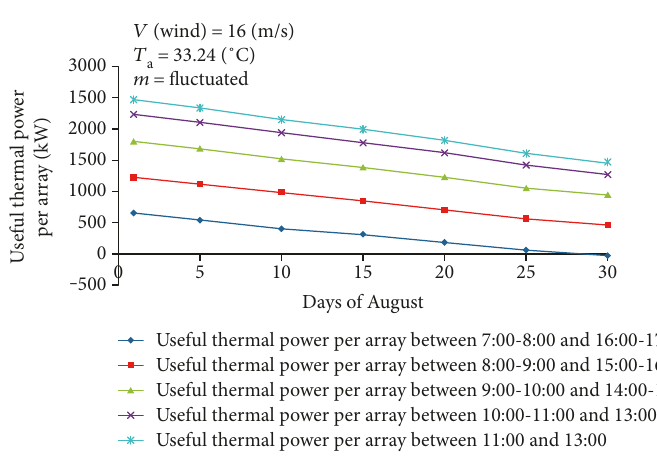
Figure 9: Useful thermal power per array for August.